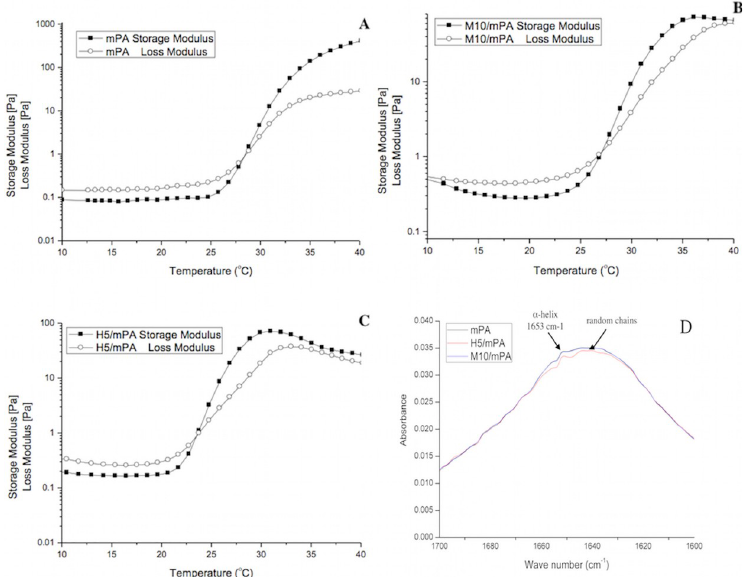
Fig 6. Dynamic rheology measurements: Storage modulus (G 0 ) and loss modulus (G 00 ) of (A) mPA, (B) M10/mPA, (C) H5/mPA as a function of temperature. (D) The FTIR spectra of mPA, H5/mPA, and M10/mPA hydrogels.